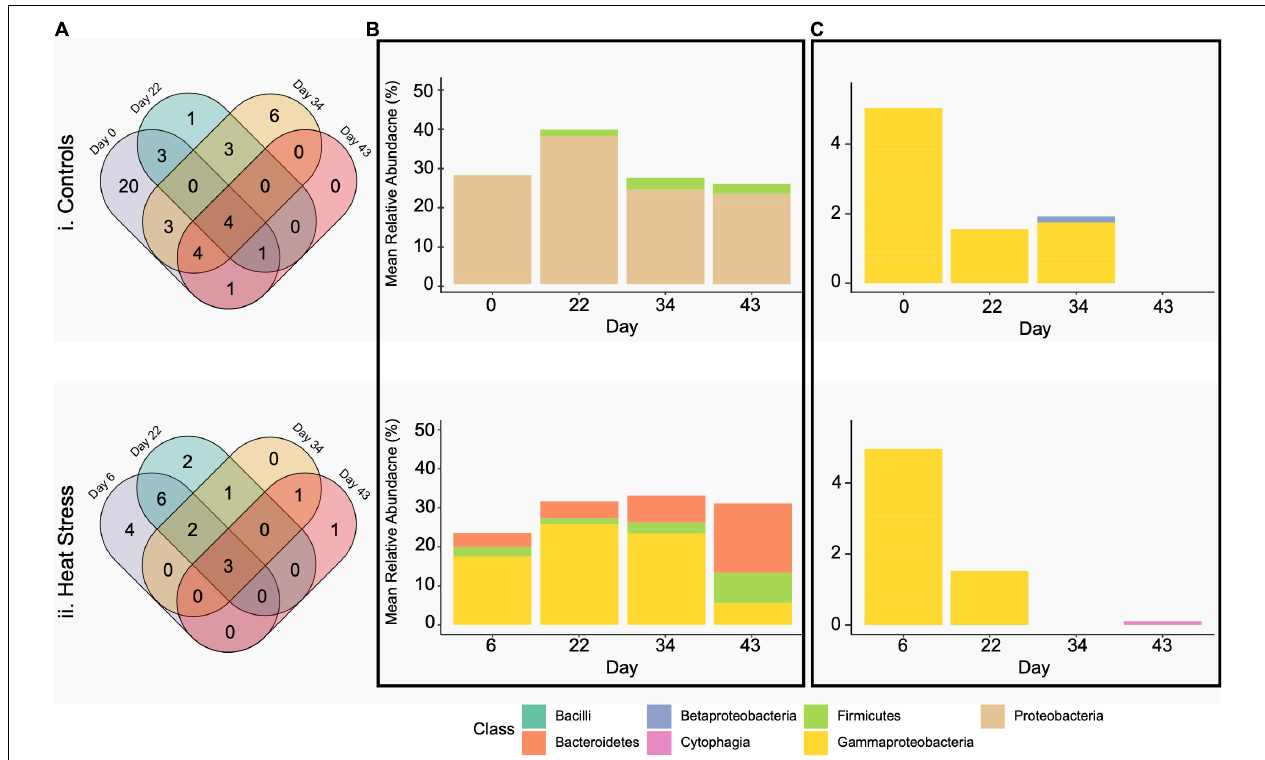
FIGURE 7 | Venn diagrams (A) show common bacterial phylotypes shared between P. damicornis colonies by treatment crossed with timepoint at 80% prevalence, separated into controls (i) and heat stress (ii). Bar plots are average percent relative abundance by class of bacterial phylotypes present in the P. damicornis (B) core and (C) environmentally responsive